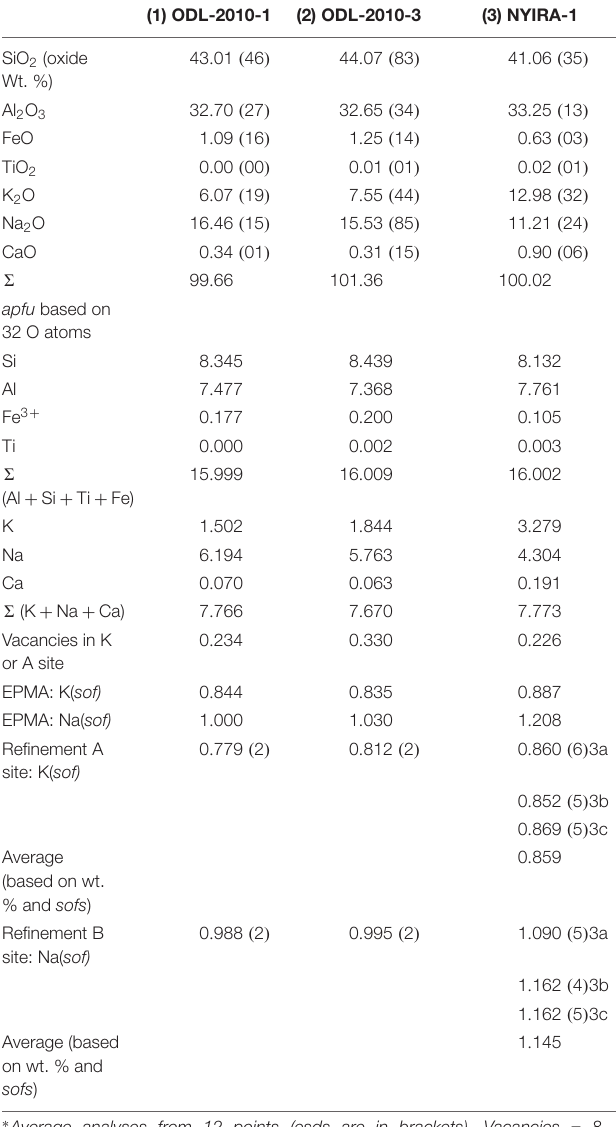
TABLE 1 | Chemical composition ∗ for three nepheline samples from